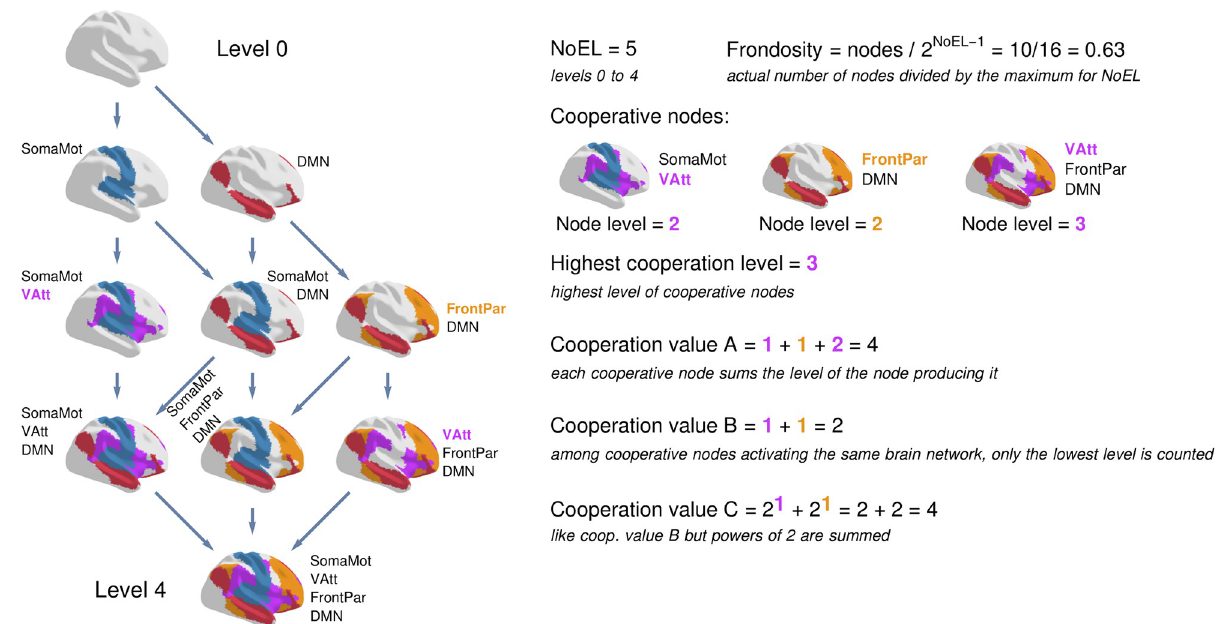
Fig 2. Measures of information structures. An information structure (IS) is shown on the left. It is determined by the structural connectivity matrix (fixed) and the α values (variable at each instant) for the 7 networks in Yeo’s parcellation. The nodes of the information structure correspond to i stationary states of the system. Networks with a value greater than 0 are coloured. The IS can be studied through several measures. NoEL (number of energy levels) corresponds to the number of layers in the IS (levels 0 to 4). Frondosity is the ratio of nodes in the IS with respect to the maximum for its NoEL. Cooperation measures focus on cooperative nodes, which are those (except for level 1) where a network that does not appear on its own occurs in presence of other networks. The highest cooperation level is given by the highest level at which a cooperative node appears. Cooperation values consider cooperative nodes in different ways. Cooperation value A counts all cooperative nodes, adding in each case the level of the node from which it proceeds. Cooperation value B considers only one level (the lowest) for each new network, and cooperation value C operates in the same way but by adding powers of 2. Other used measures are criticality and synchronicity . Criticality measures how close is the globally stable node to a bifurcation point that modifies which are its active and inactive networks. Finally, synchronicity measures the ratio of IS of a subject (across time) in which all networks appear in the same state (active or inactive) in the globally stable solution.